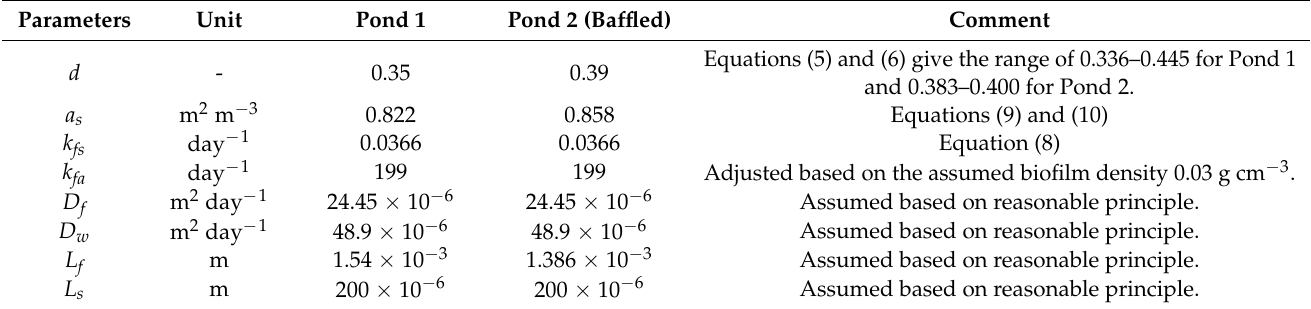
Table 4. The calculation of model parameters at 20 ◦